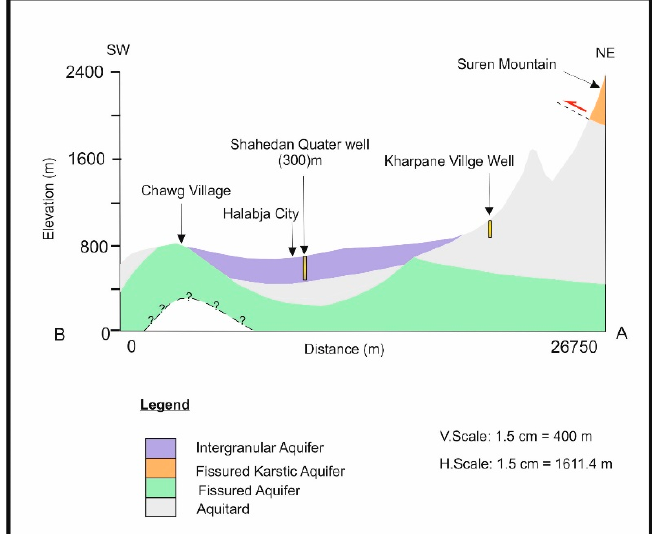
Figure 4. Hydrogeological cross section along the A–B line for the HSB.